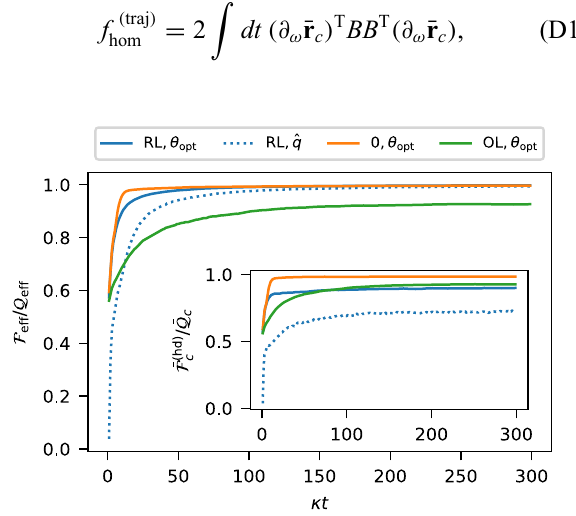
FIG. 10. Ratio between the effective Fisher information F eff for final homodyne detection and the effective QFI of the condi- ¯ Q κ t for the three different strategies tional state eff as a function of (the inset shows the ratio between the average Fisher informa- ¯ F ( hd ) tion of the strong homodyne measurement and the average c ¯ Q ¯ F QFI hd,opt c .) The solid lines show the Fisher information optimized over θ , while the dotted line shows the Fisher infor- ¯ F ˆ q for mation hd,Oq obtained with a homodyne on the quadrature the RL strategy. In all cases, while not being optimal, homodyne detection allows one to extract a significant fraction of the total available information on the frequency ω (parameter values are fixed as in Fig.